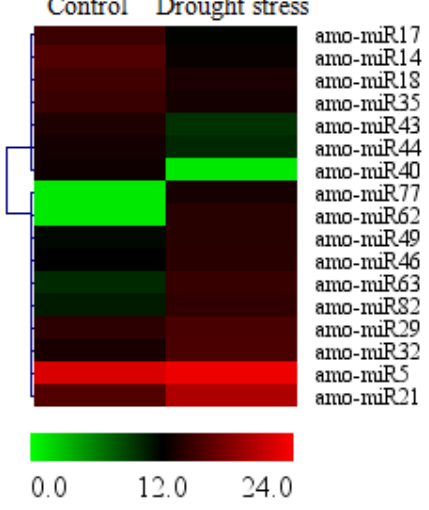
Figure 3. Expression profile of 17 miRNAs under drought and normal conditions.